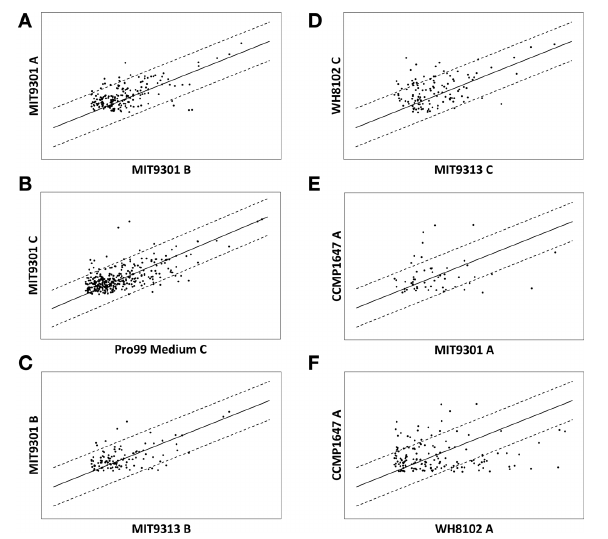
FIGURE 4 | Scatter plots illustrating variations in signal intensity among features common to multiple samples. Signal intensity is used as a semi-quantitative proxy for feature abundance. Features are indicated by dots and their location is a function of their signal intensity in the 2 samples labeled on the axes for each plot. Solid lines indicate 1:1 and broken lines indicate 4:1. Variations in common feature intensities are shown for biological replicates (A) indicating some abundance variation among replicate samples. Comparing a culture sample to its respective media control (B) reveals features present in the medium that are produced (above the upper broken line) and consumed (below the lower broken line) by the phytoplankton strain during growth in culture. Variations in common feature intensities can also be compared at multiple levels of phylogenetic variation including at the clade-level (C) , genus-level (D), and domain level (E,F) , indicating that the quantity of features produced is also related to producer